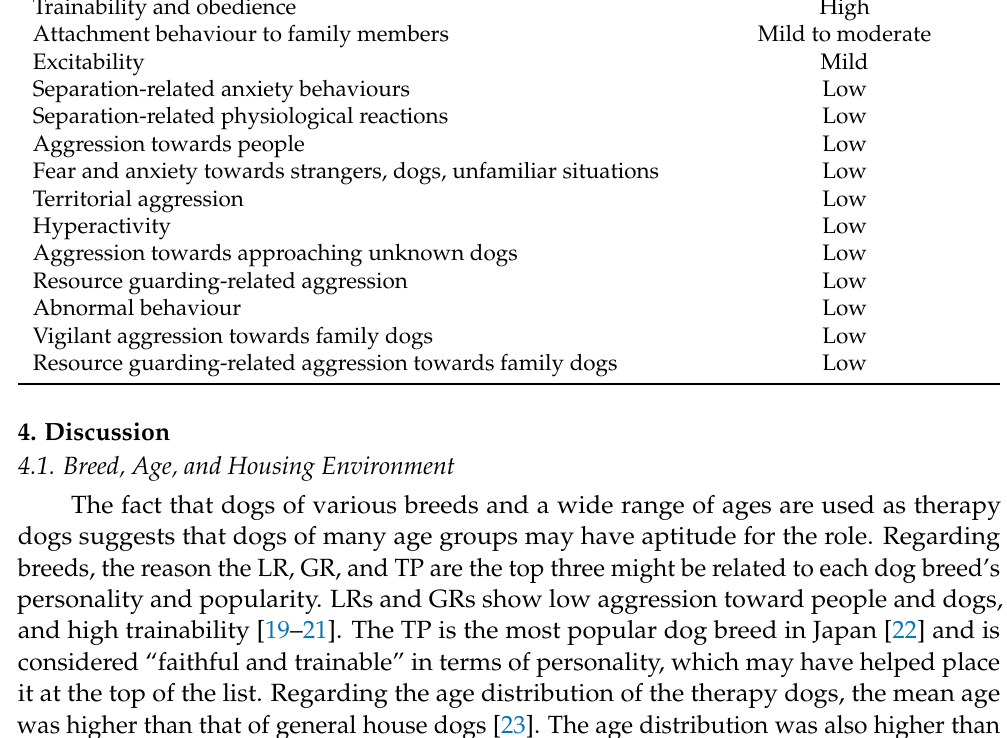
Table 2. Trends in each factor of therapy dog temperament traits. Factor Trend Trainability and